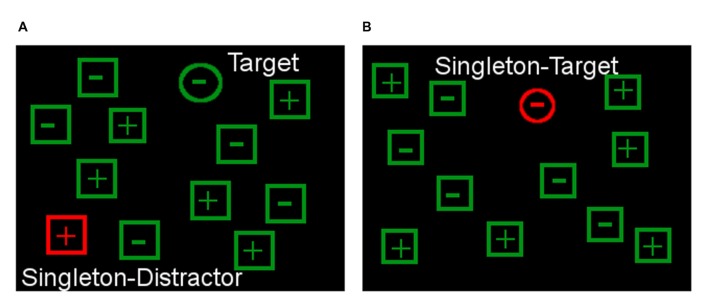
Attentional control paradigm. The task is to respond to the symbol depicted in the target shape (circle) and ignore the singleton distractor (A). Demands on flexible attentional control can be raised by including trials in which the singleton can become the target (B) so that it cannot be blanked out from the start.